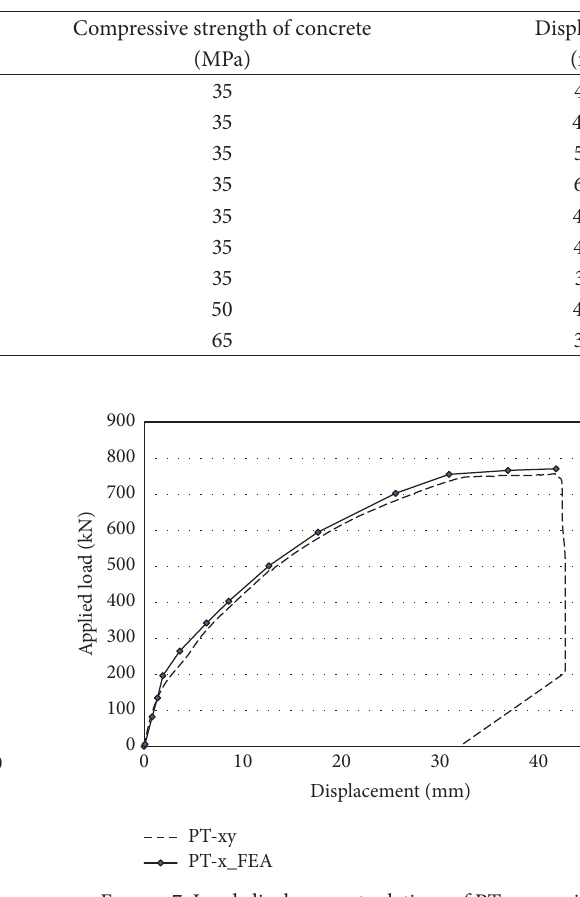
Figure 6: Load-displacement relations of PT-x specimen. Figure 7: Load-displacement relations of PT-xy specimen.